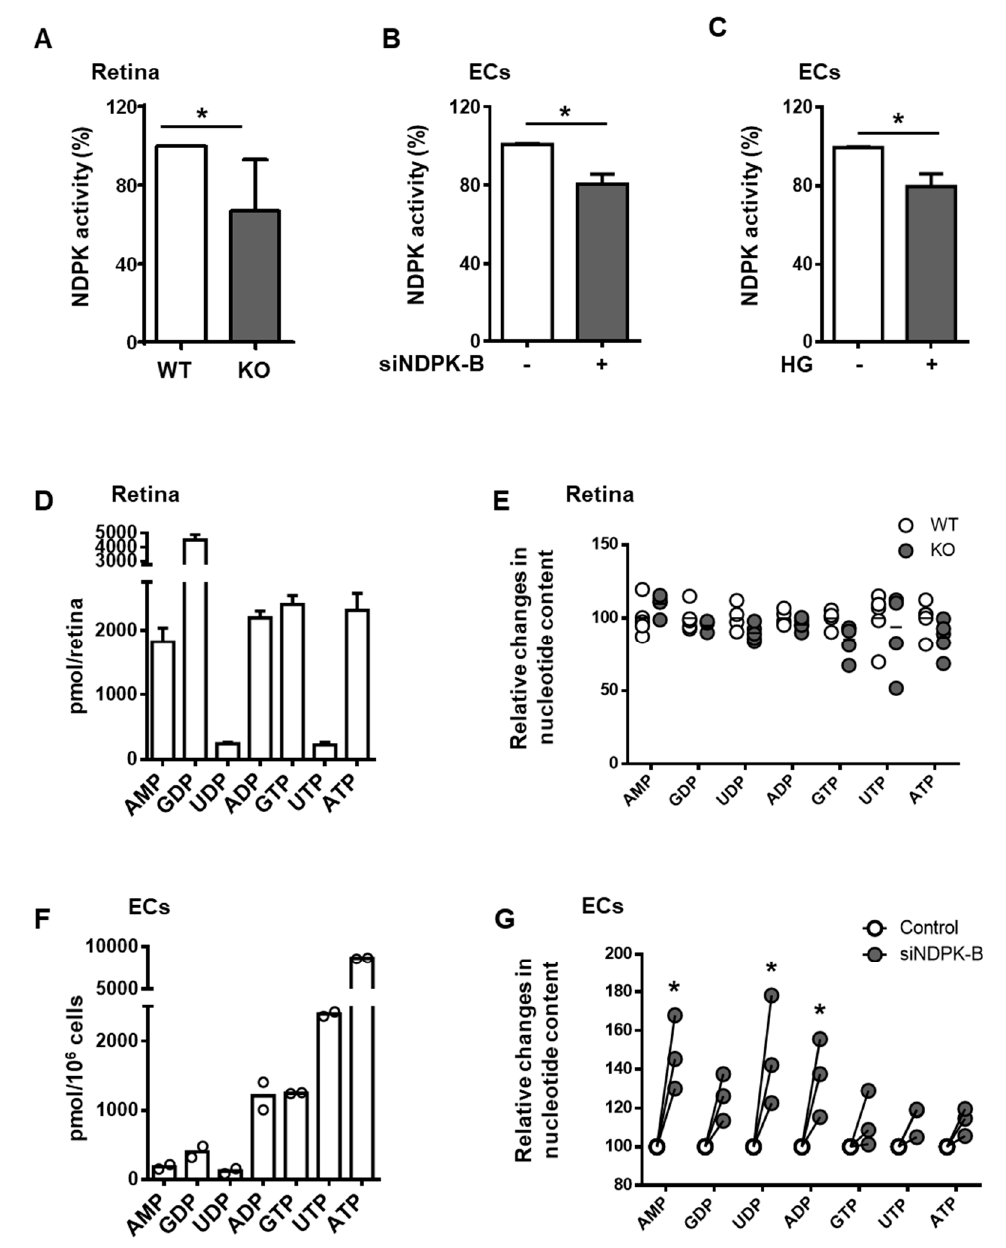
Figure 2. Loss of NDPK-B in ECs alters nucleotide metabolism without changing NTP levels. ( A ) NDPK activity in lysates of WT and KO retinae (n = 10 mice per genotype). ( B ) NDPK activity in HUVECs transfected with either scrambled control ( − ) or siRNA against NDPK-B (siNDPK-B, +) (n = 8). ( C ) NDPK activity in HUVECs treated with either normal ( − ) or high glucose (HG, +) (n = 9). ( D ) UPLC-PDA analysis of absolute values of nucleotide composition in the retina in pmol/retina. ( E ) Quantification of the indicated nucleotides between WT and KO retinae by UPLC-PDA (n = 5 mice per genotype). ( F ) UPLC-PDA analysis of absolute values of nucleotide composition to assess the proportional contents of the nucleotides in HUVECs, presented in pmol/10 6 cells (n = 2). ( G ) Relative comparison of nucleotides in control transfected and NDPK-B depleted HUVECs (n = 3). Mean values in control cells were set to 1.0. WT: wild type; KO: NDPK-B knockout, HUVECs: human umbilical vein endothelial cells. Results are displayed as mean ± SD; *: p < 0.05.